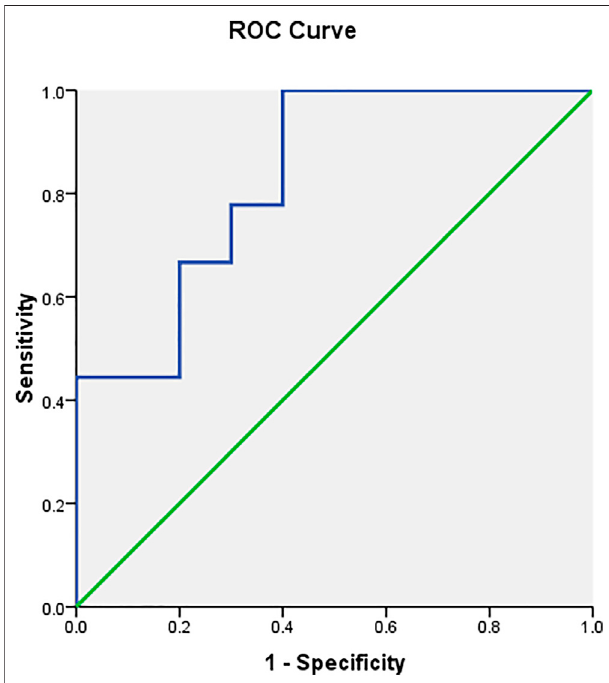
FIGURE2| ROCcurve analysisshowingthatserumprolactinlevelhasa high accuracy (68 – 78%) for identifying responders and non-responders.